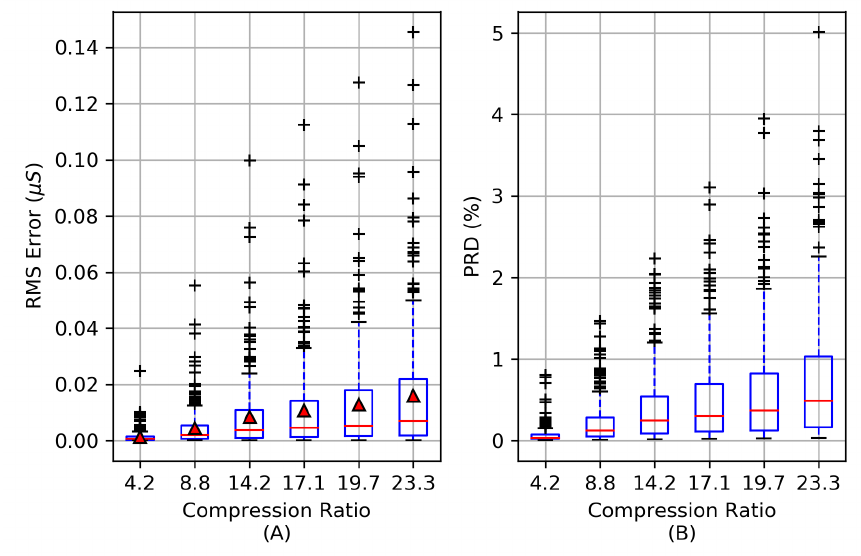
Figure 8. The root mean square error (RMSErr) is shown in ( A ) of 253 EDA signals at a range of compression ratios. The mean RMSErr at each compression ratio is indicated by red triangles. The percent root mean square difference (PRD) distortion in ( B ) is minimal for CRs below 14.2 × while the upper quartile range remains below 1% for CRs up to 19.7 × .